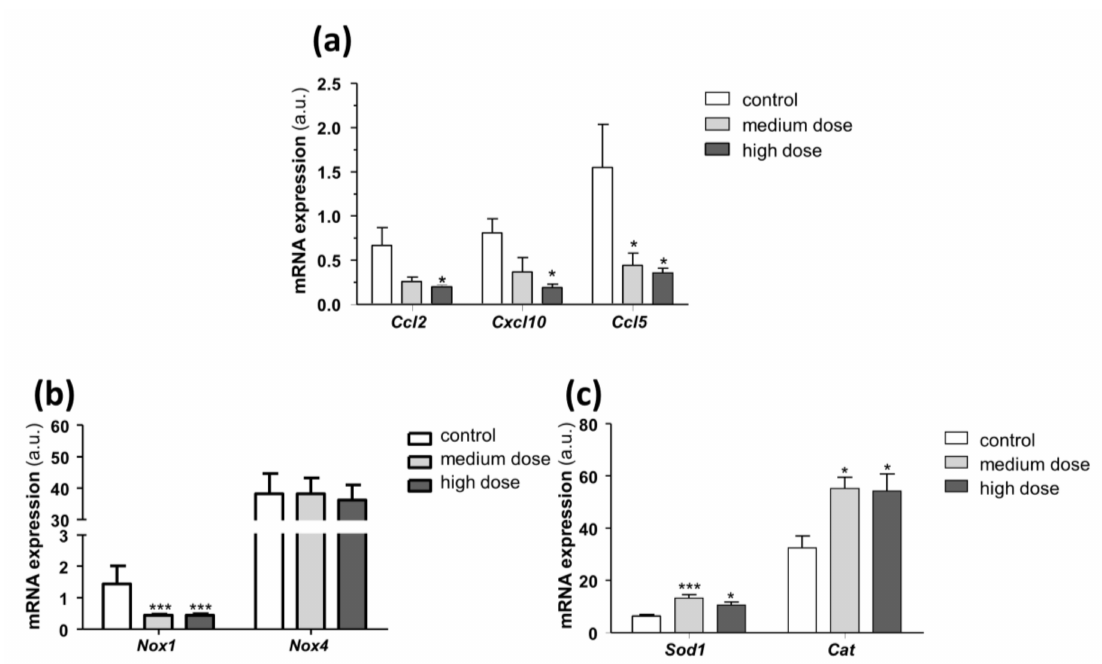
Figure 5. In vivo e ff ects of PS5 on pro-inflammatory and redox-related genes. Real-time PCR analysis in aortic samples from ApoE KO mice untreated (control) and treated with medium- and high-dose PS5 peptide (38 and 79 µ g / mouse, respectively). The mRNA expression levels of ( a ) Ccl2, Cxcl10 and Ccl5 chemokines, ( b ) Nox1 and Nox4 pro-oxidant enzymes and ( c ) Sod1 and Cat antioxidant enzymes, were normalized to 18S and expressed as arbitrary units (a.u.). Results are presented as the mean ± SEM of n = 6–7 animals per group. * p < 0.05 and *** p < 0.001 vs.